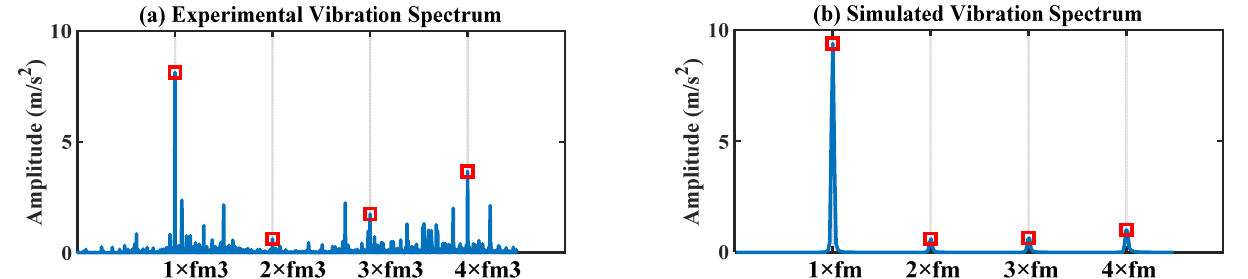
Figure 13. Comparison of experimental vibration spectrum and simulated vibration spectrum .